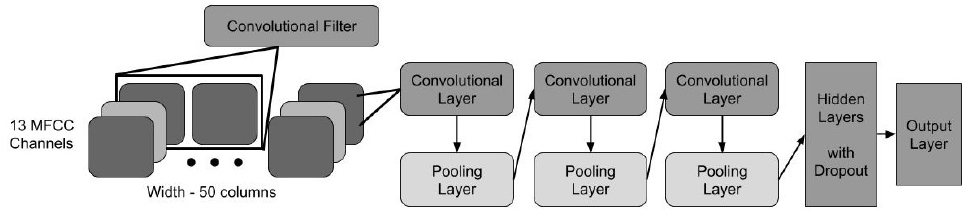
Figure 8. Representation of the 1D convolutional neural network (CNN) four class sibilants